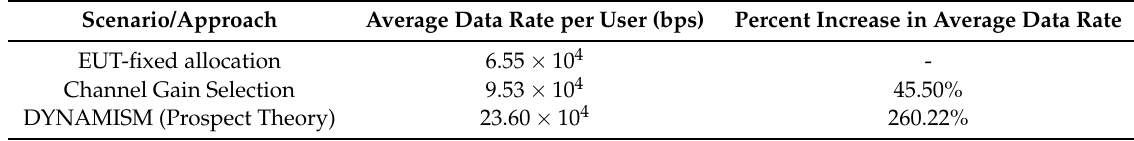
Table 2. Average user data rate and percent increase in various UAV selection